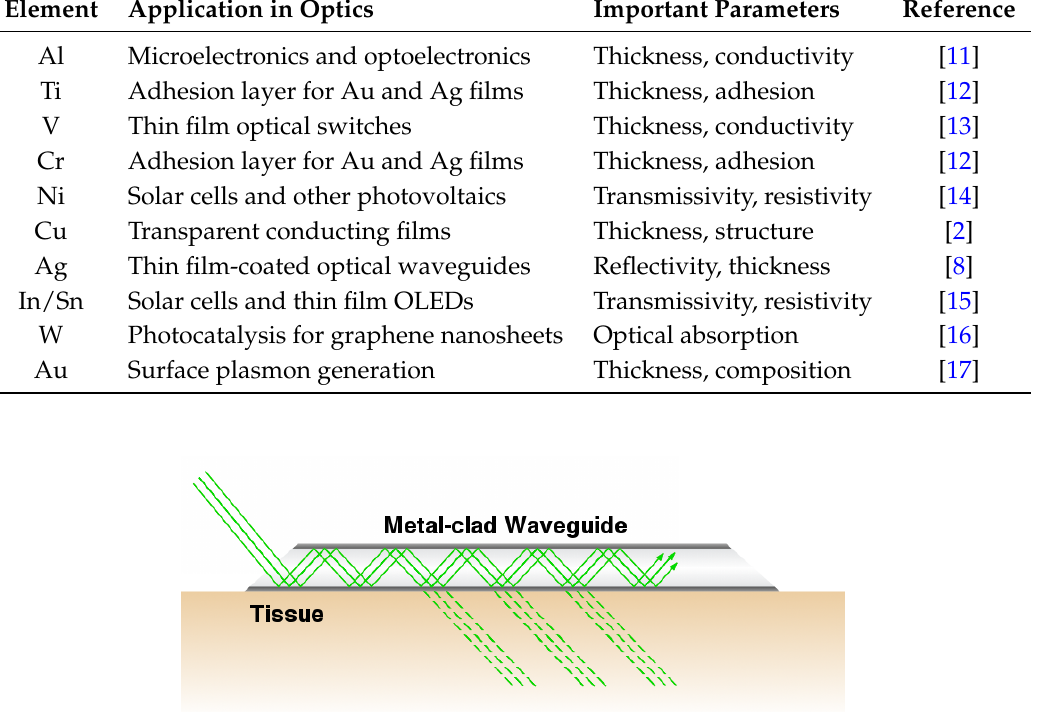
Figure 1. Regarding the example of a metal-coated optical waveguide, the metal thin film serves as a cladding layer to restrict the laser light within the bounds of the substrate; however, upon contact with the tissue, depending on the thickness of the metal film, the light may transmit out of the waveguide